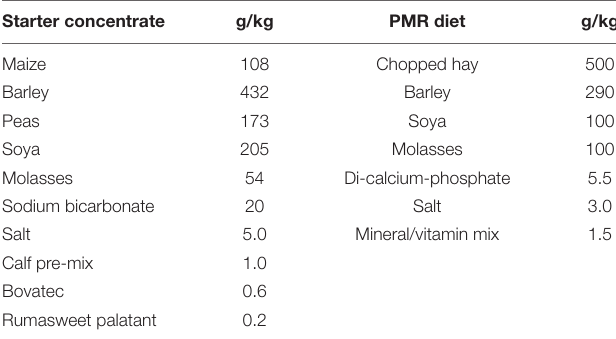
TABLE 1 | Ingredients of the starter concentrate and the partial mixed ration (PMR) diet.